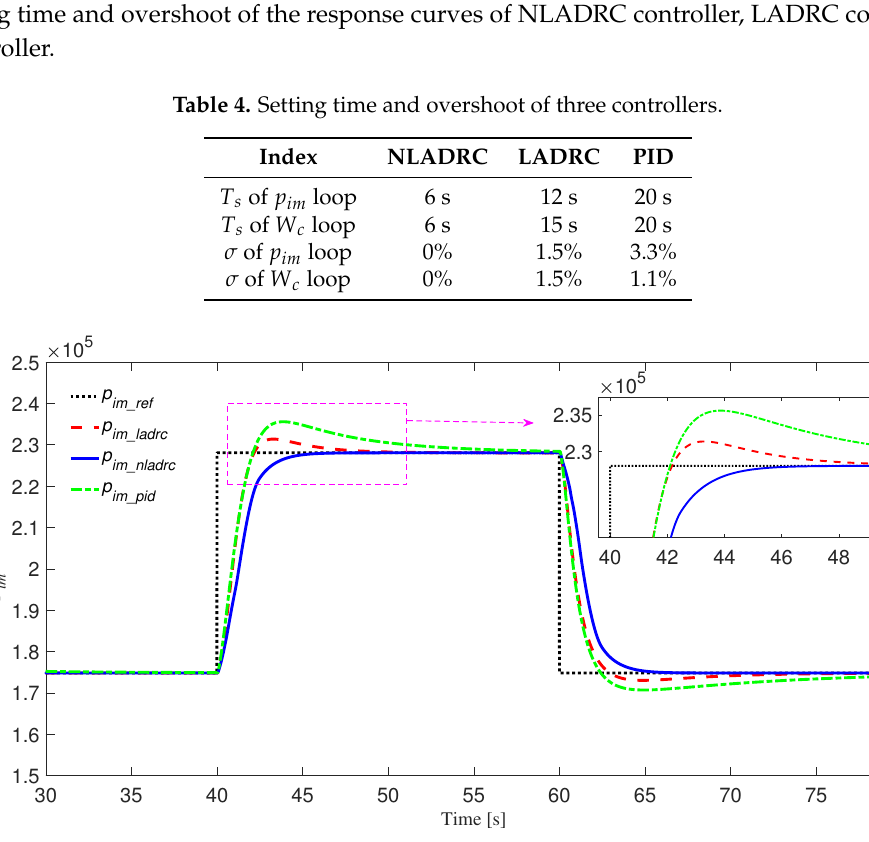
Figure 4. Response curve of intake manifold pressure p im